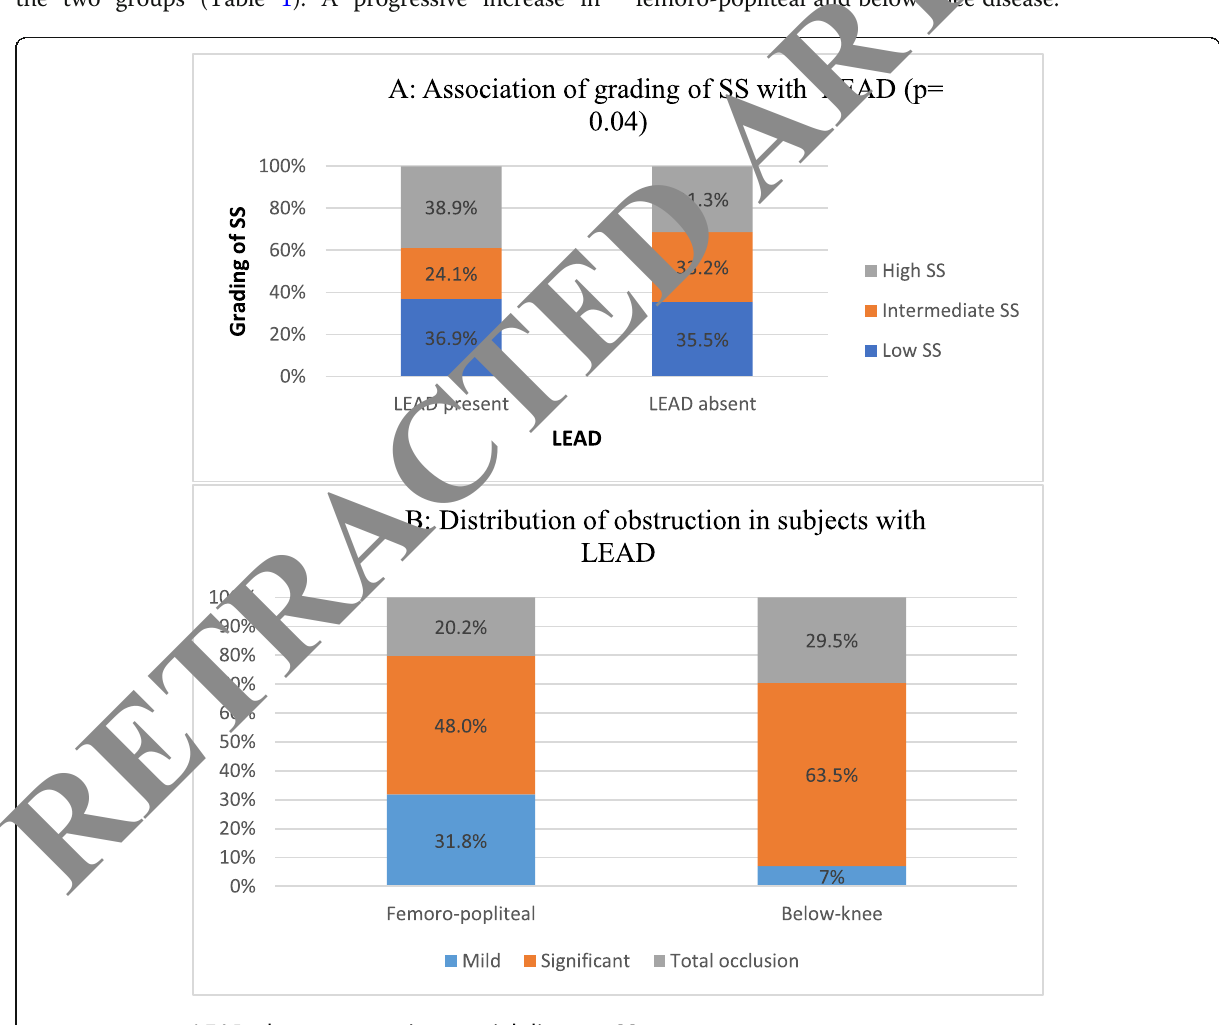
Fig. 1 a Association of grading of SS with LEAD ( p = 0.04). b Distribution of obstruction in subjects with LEAD. LEAD, lower extremity arterial disease; SS, SYNTAX